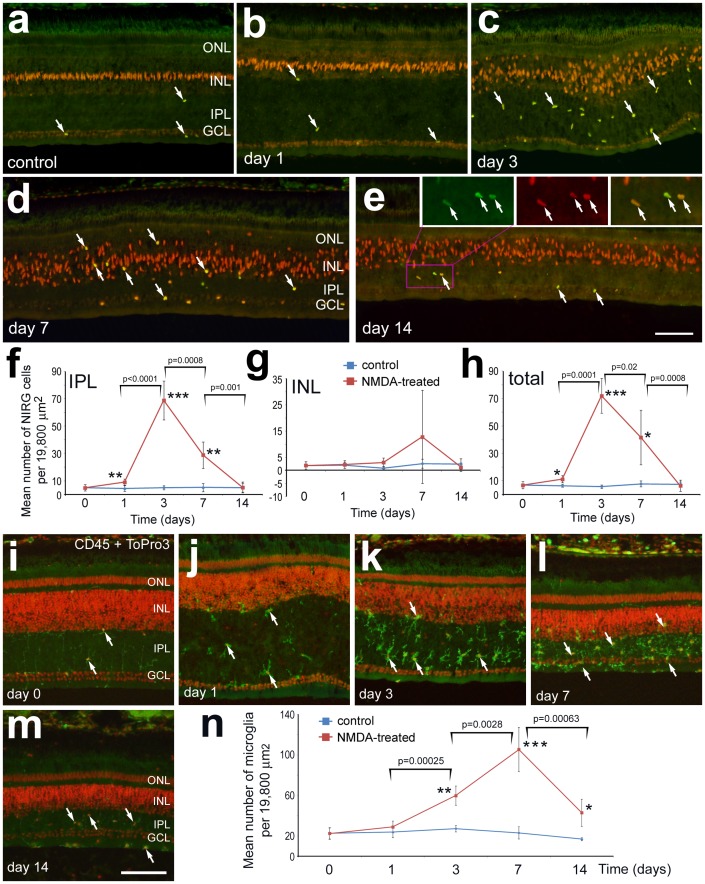
NIRG cells and microglia transiently accumulate in the retina following NMDA-induced excitotoxic damage.Retinas were obtained from eyes treated with NMDA at P7 and harvested at P8 (day 1), P10 (day 3), P14 (day 7) and P21 (day 14). Vertical sections of the retina were labeled with antibodies to Nkx2.2 (green) and Sox9 (red) (a–e), or CD45 (green) and ToPro3 (red) (i–m). Arrows indicate the nuclei of NIRG cells that are labeled for Nkx2.2 and Sox9 (a–e) or CD45-positive microglia (i–m). Plots illustrate the mean (±SD) number of NIRG cells (f–h) or microglia (n) per 19,800 µm2. Significance of difference among groups was determined by using a one-way ANOVA (p<0.0001). Significance of difference between control and treated groups (*p<0.05, **p<0.001, ***p<0.0001), and between treatment time-points (brackets and p-values) was determined by using a post-hoc two-tailed Student’s t-test. The scale bar (50 µm) in panel e applies to a–e, and the bar in m applies to i–m. Abbreviations: ONL – outer nuclear layer, INL – inner nuclear layer, IPL – inner plexiform layer, GCL – ganglion cell layer.